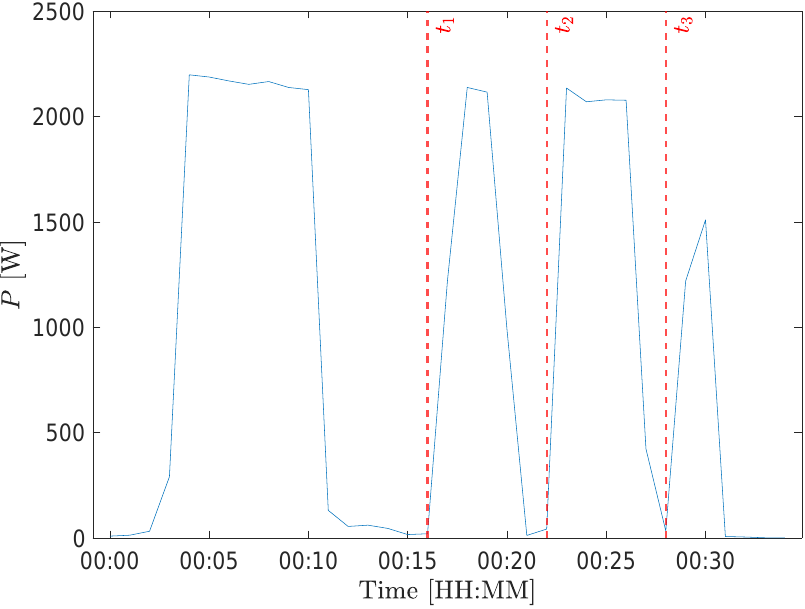
Figure 8. Profile of an exemplary